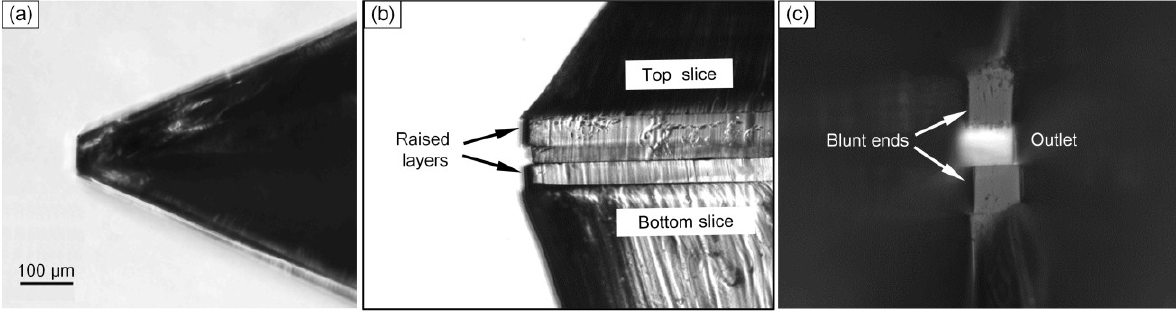
Figure 4. Micrographs of the corner integrated emitter. ( a ) Top view of the c. 75 μm blunt tip of the 45° corner; ( b ) Lateral view of the tip, the micro-channel layer lies between the two raised layers; ( c ) Front view of the tip: the blunt ends and outlet are clearly